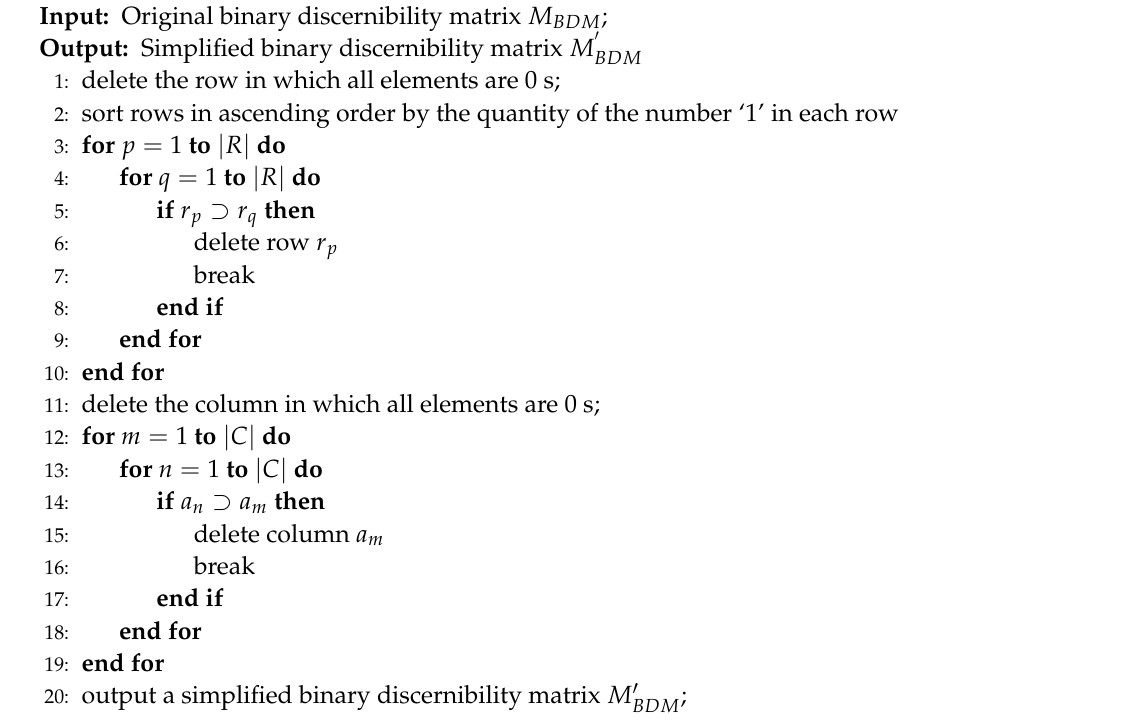
Algorithm 2 : An improved algorithm of binary discernibility matrix reduction, IBDMR